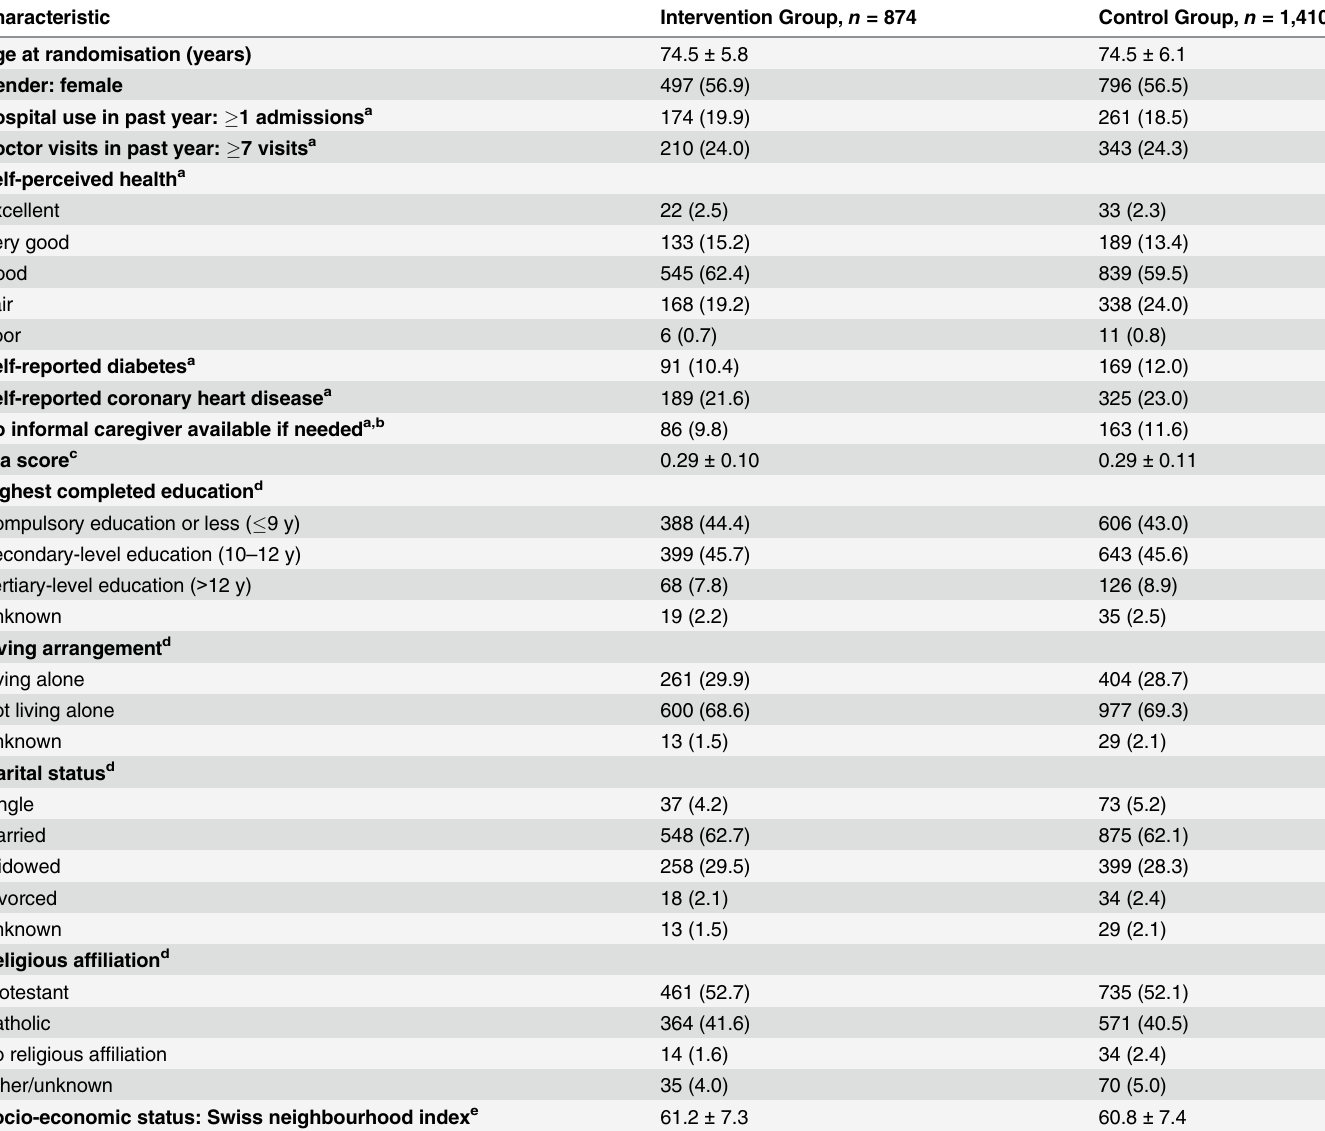
Table 2. Baseline characteristics of study